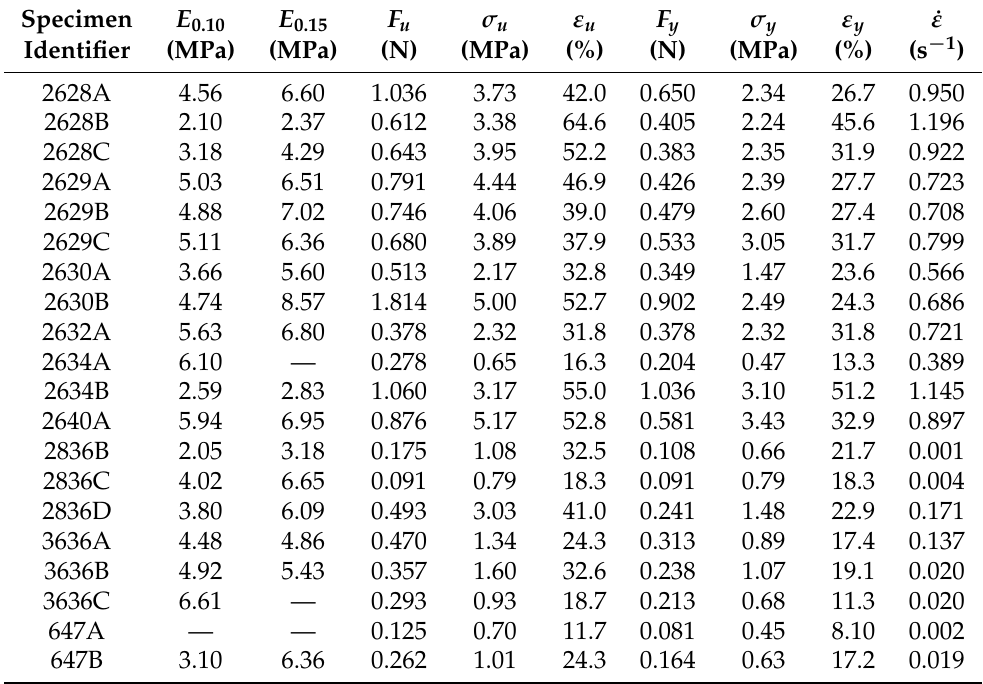
Table 1. Basic mechanical properties of the CBV